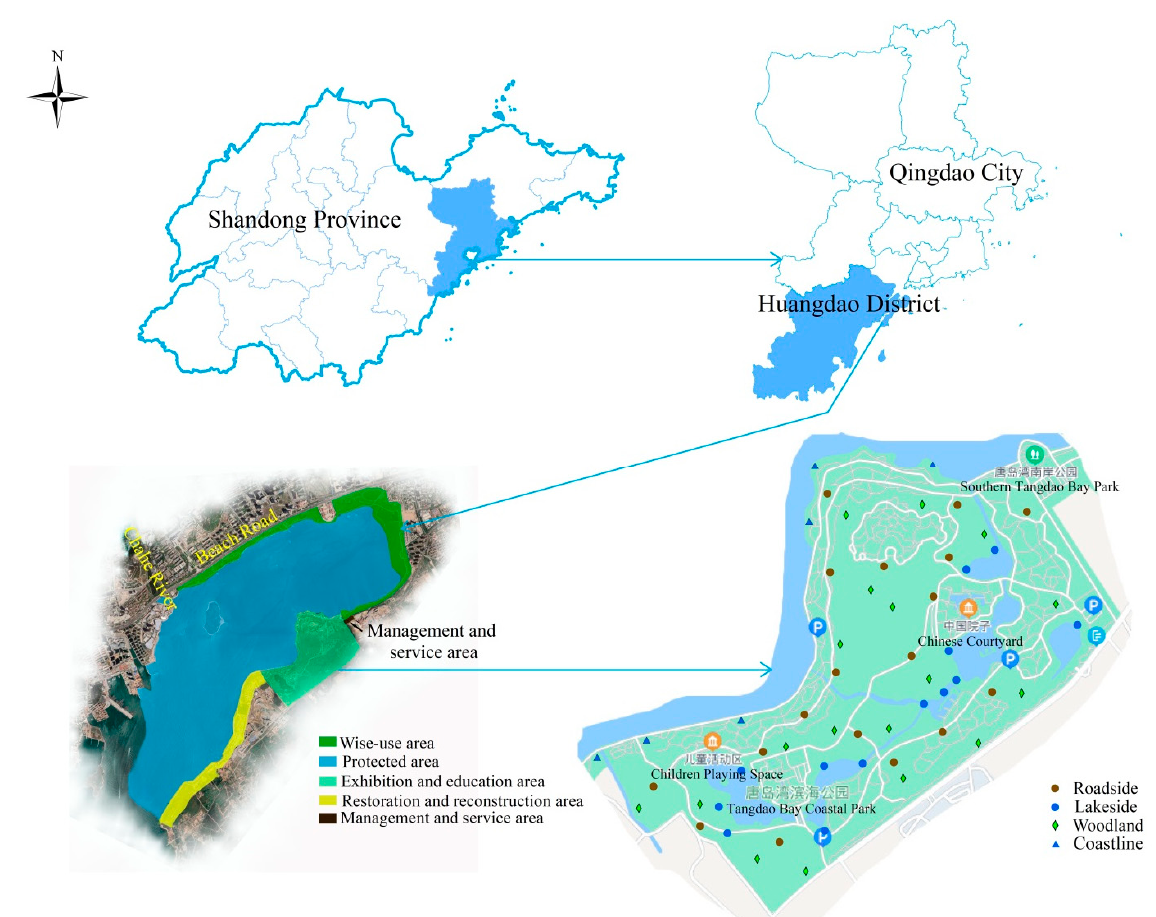
Figure 1. Study area and locations of sampling quadrats.